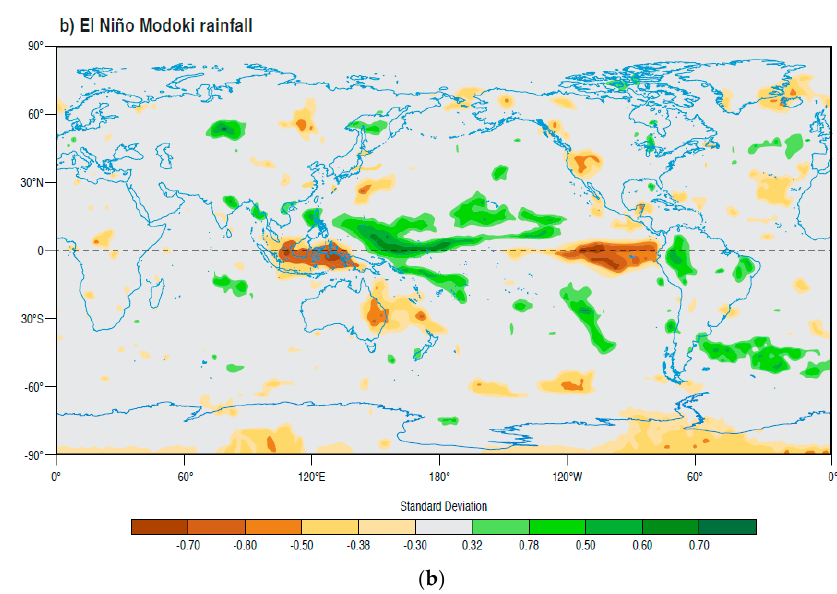
Figure 9. Rainfall anomalies for ( a ) El Niño and ( b ) El Niño Modoki events. Sourced and redrawn from Japan Agency for Marine, Earth Science and Technology. http://www.jamstec.go.jp/frcgc/research/ d1/iod/enmodoki_home_s.html.en.